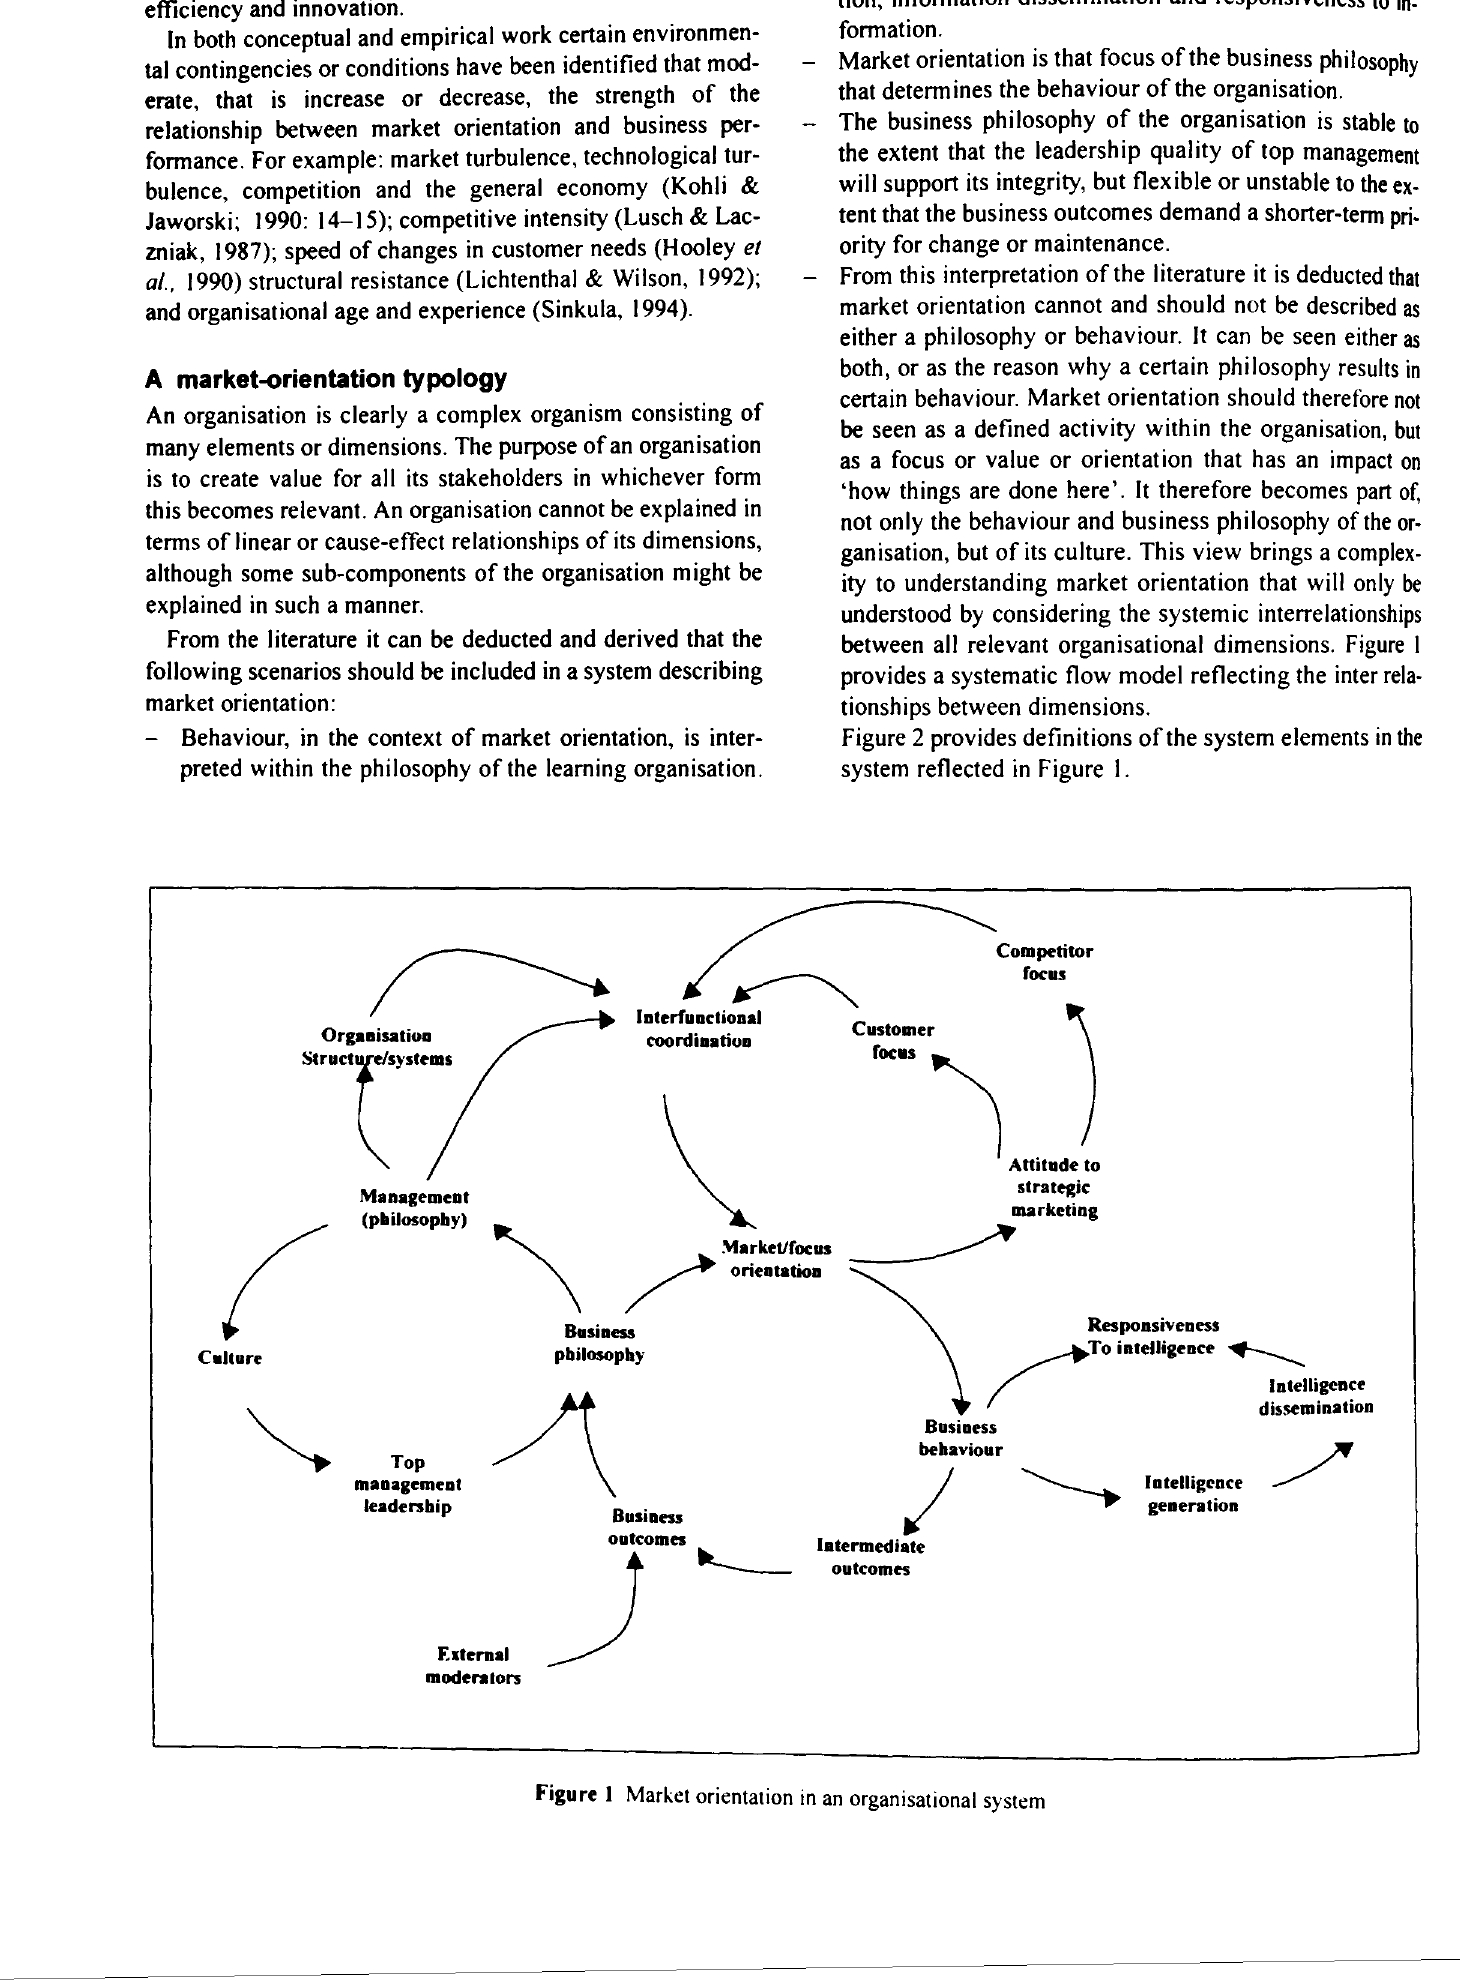
Figure I Market orientation in an organisational